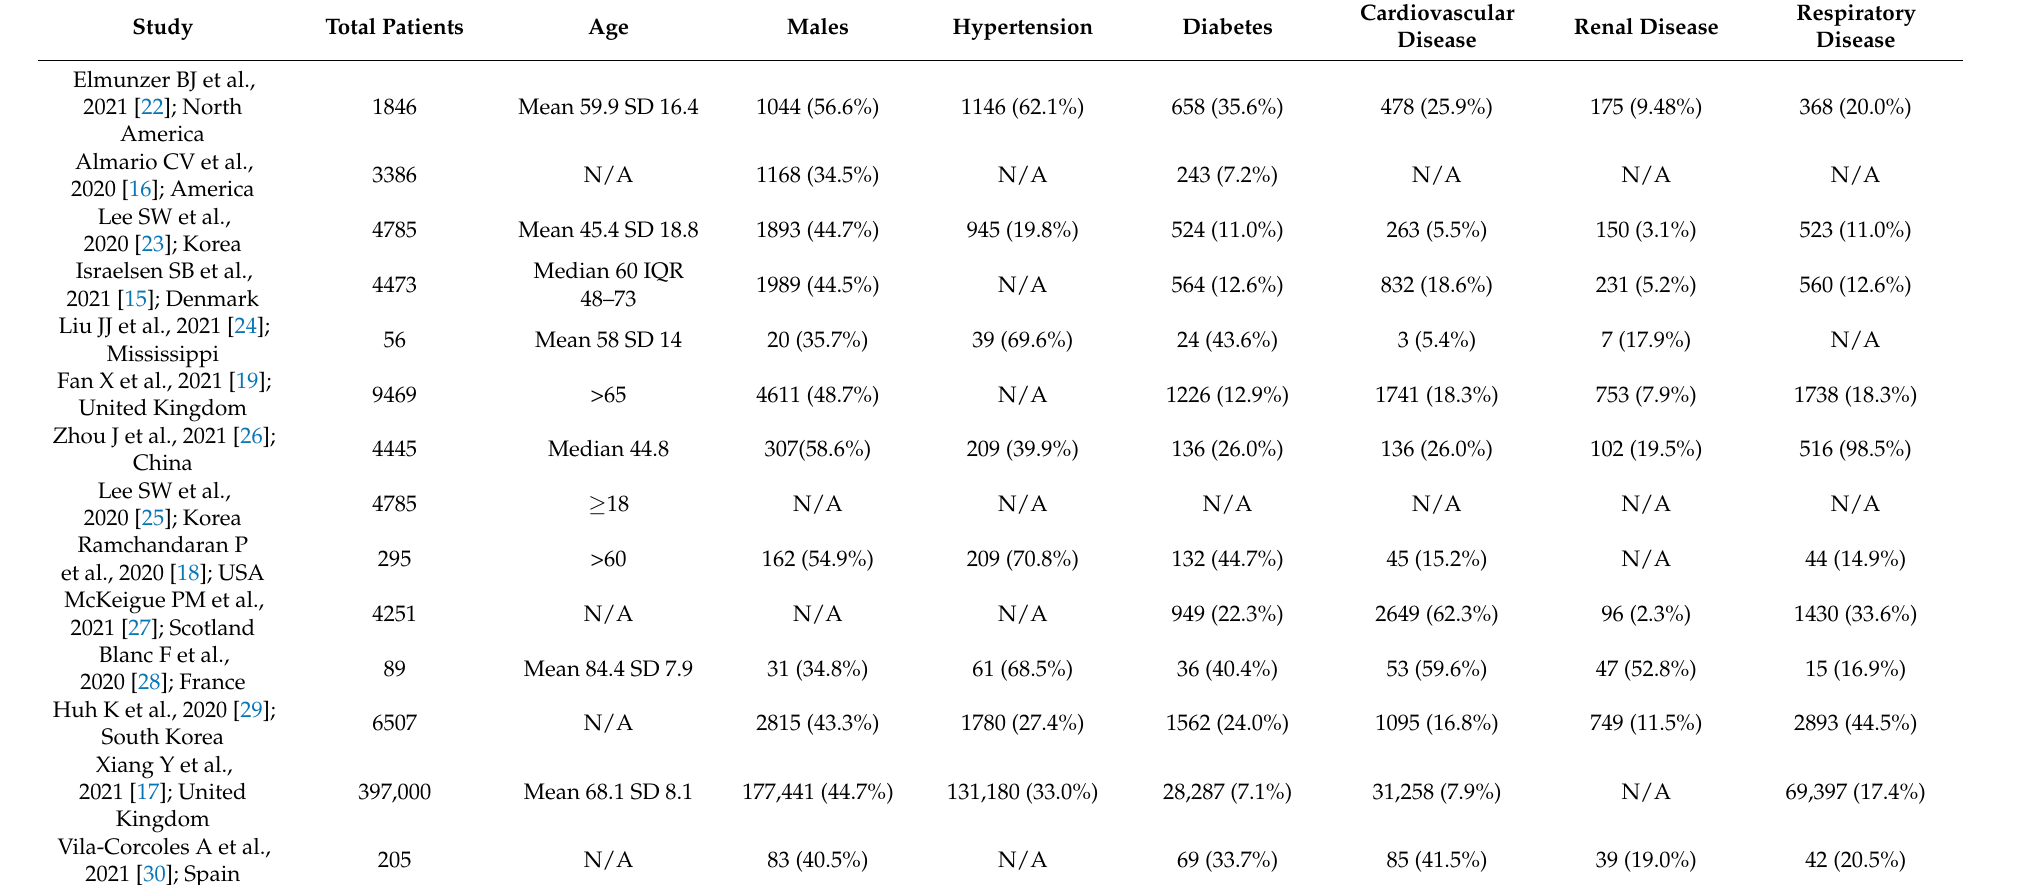
Table 2. Baseline patient